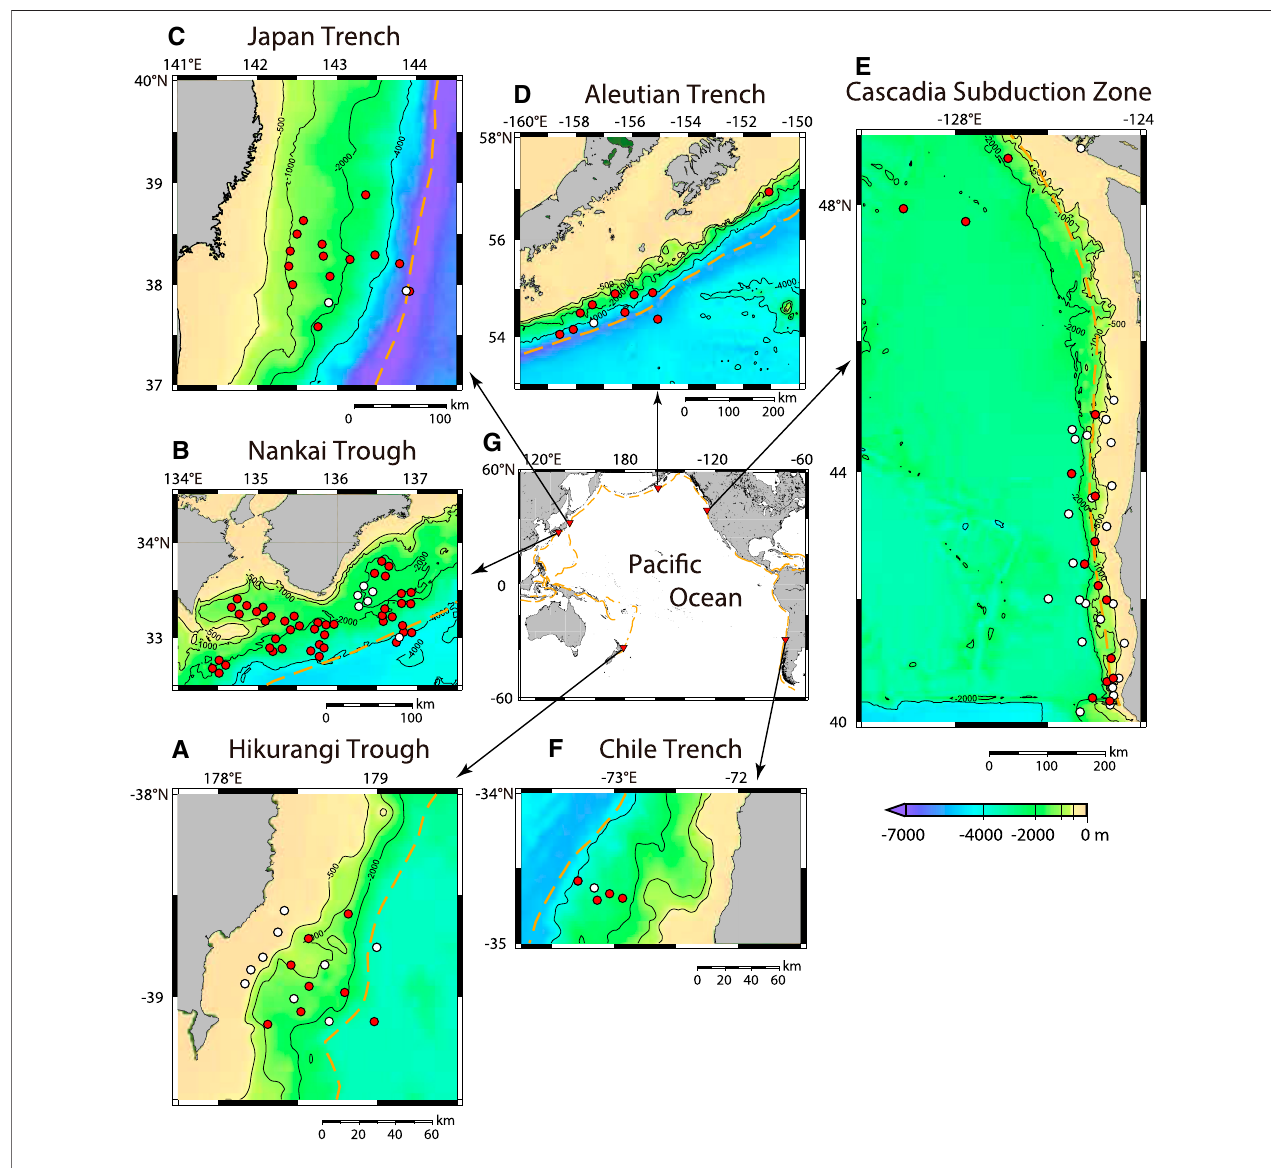
FIGURE1| OceanbottompressureobservationsatsixsubductionzonesaroundthePaci fi cOcean.Thesixsubductionzonesare (A) theHikurangiTrough, (B) the NankaiTrough, (C) theJapanTrench, (D) theAleutianTrench, (E) theCascadiaSubductionZone,and (F) theChileTrench. (G) showsthemapofthePaci fi cOceanwith speci fi ctrench/trough axes (orange dashed lines) derived from Bird (2003).Red and whitecircles denote used and unused stations, respectively. See Table 1 for detail. Isobaths of 500, 1,000, 2,000, and 4,000 m are shown.